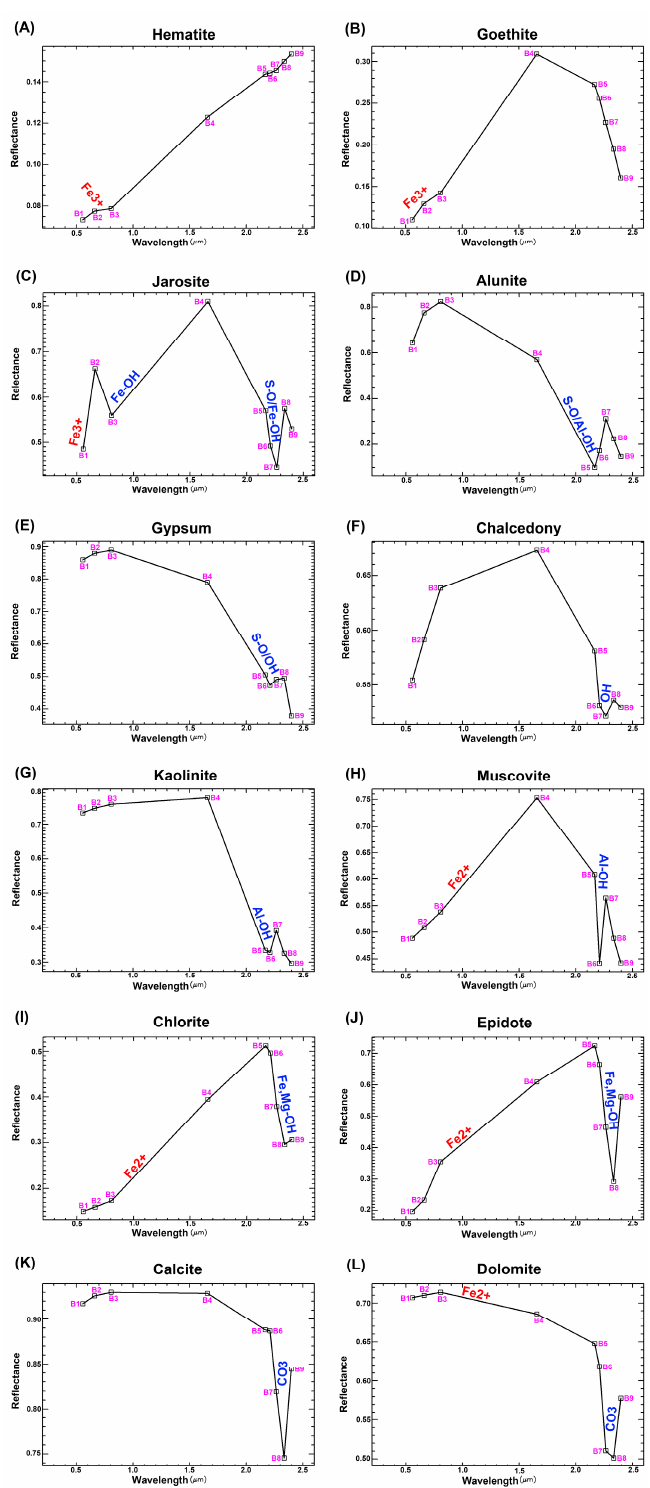
Figure 11. Laboratory reflectance spectra of the selected alteration minerals resampled to response functions of ASTER VINR/SWIR bands (0.50–2.5 µ m) [67]. ( A ) hematite; ( B ) goethite; ( C ) jarosite; ( D ) alunite; ( E ) gypsum; ( F ) chalcedony (hydrous-silica); ( G ) kaolinite; ( H ) muscovite; ( I ) chlorite; ( J ) epidote; ( K ) calcite; and ( L ) dolomite. Cubes show the location of the ASTER VINR/SWIR bands (B1 to B9) from 0.50–2.5 µ m.